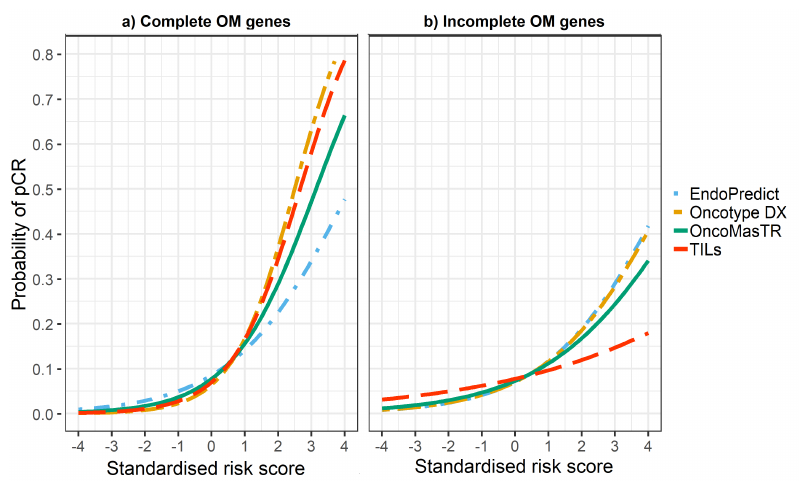
Figure 4. Predicted probability of pCR by risk score in ( a ) datasets with complete OM genes (2 datasets);